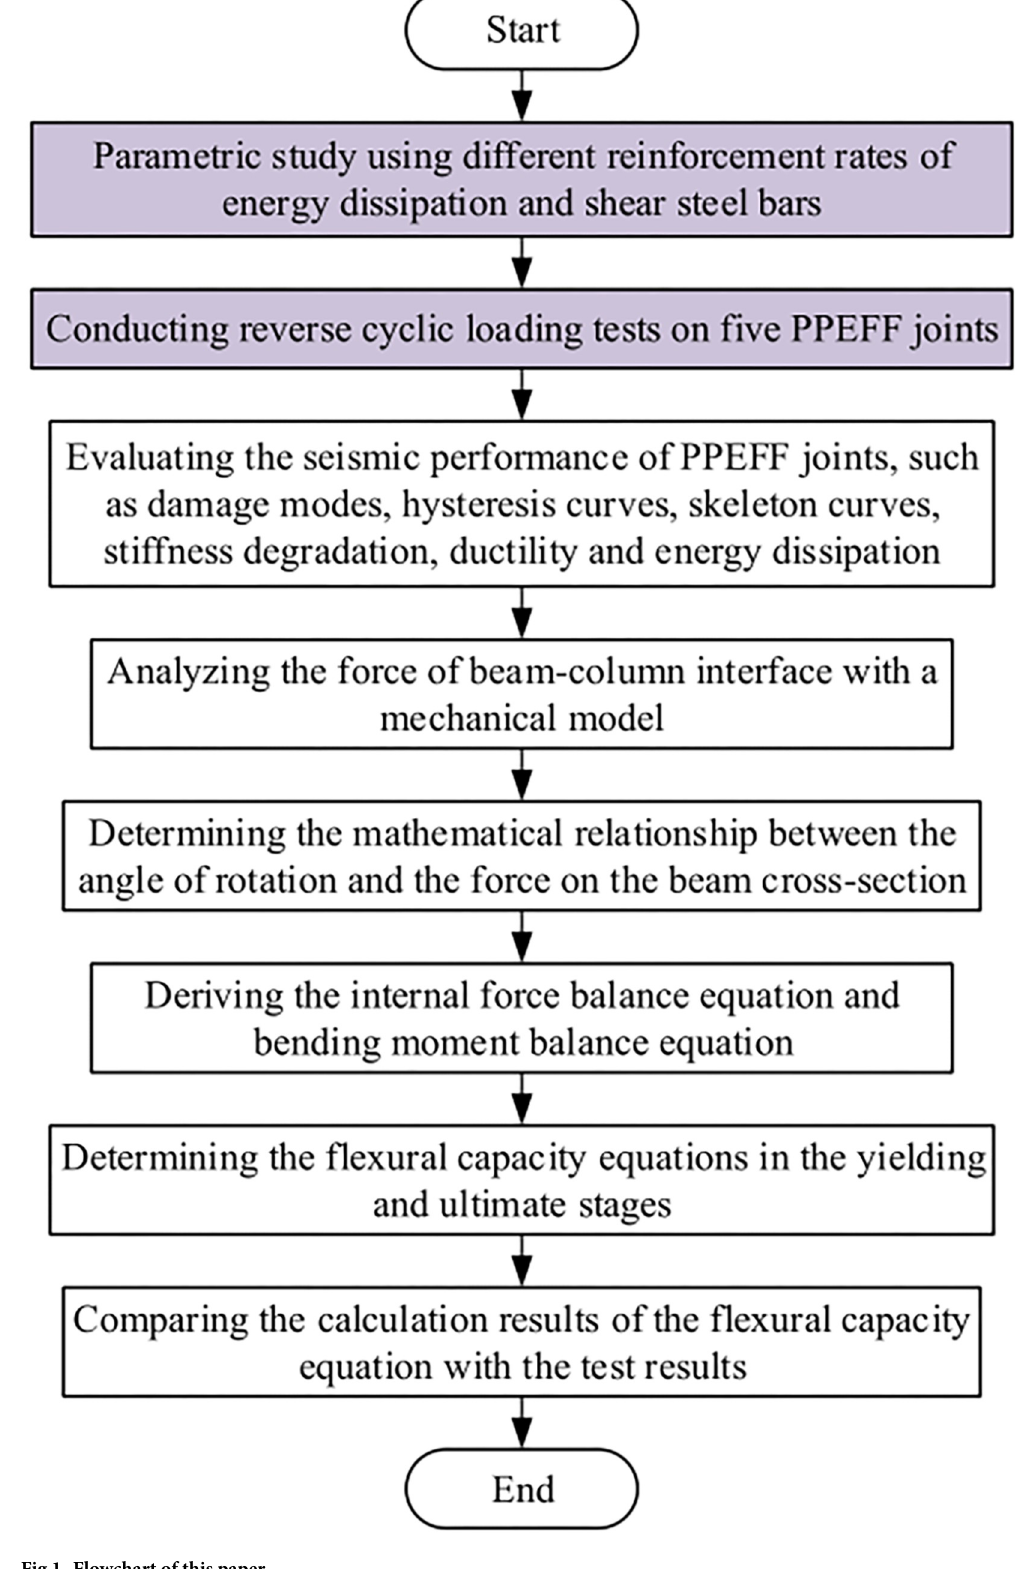
Fig 1. Flowchart of this